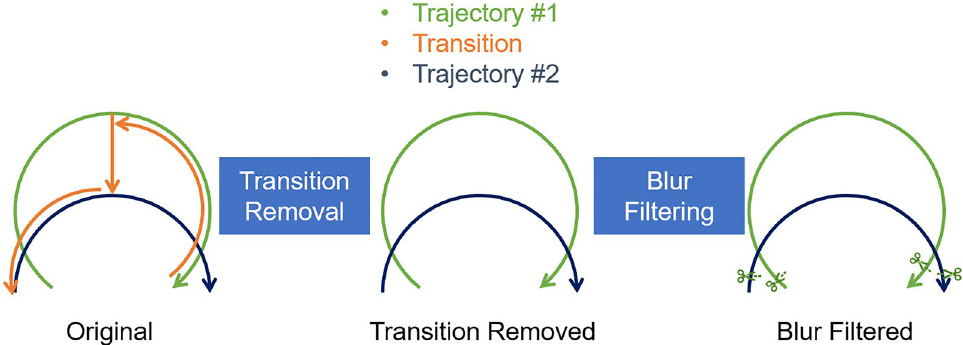
Fig. 13 The concerned datasets comparison